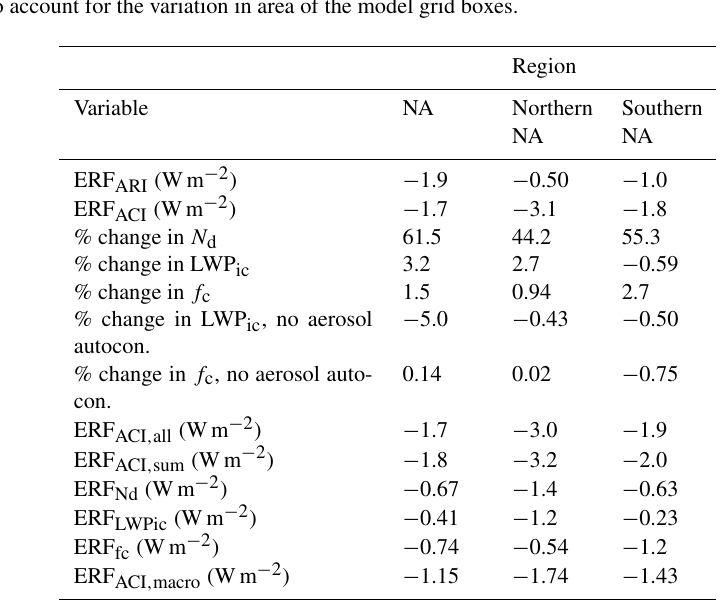
, ERF LWP and ERF f ic c d and ERF f . All ic c Region Southern NA NA